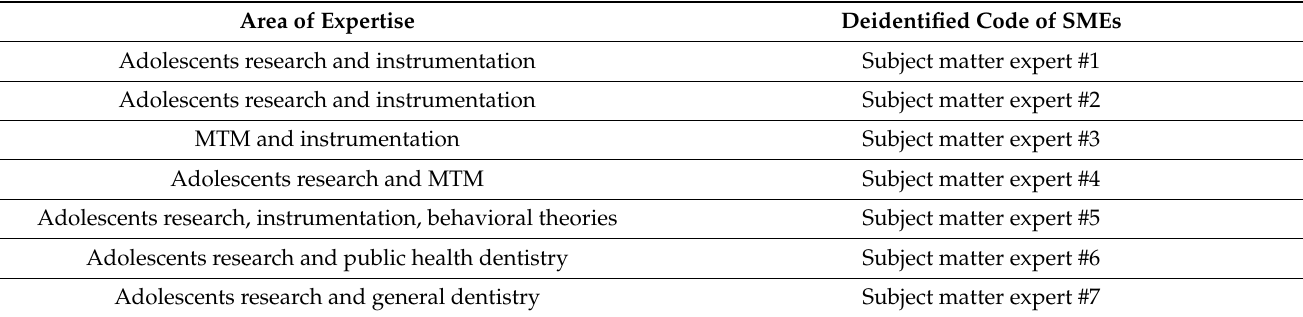
Table 1. Details regarding areas of expertise of SMEs involved in the face and content validation of the survey